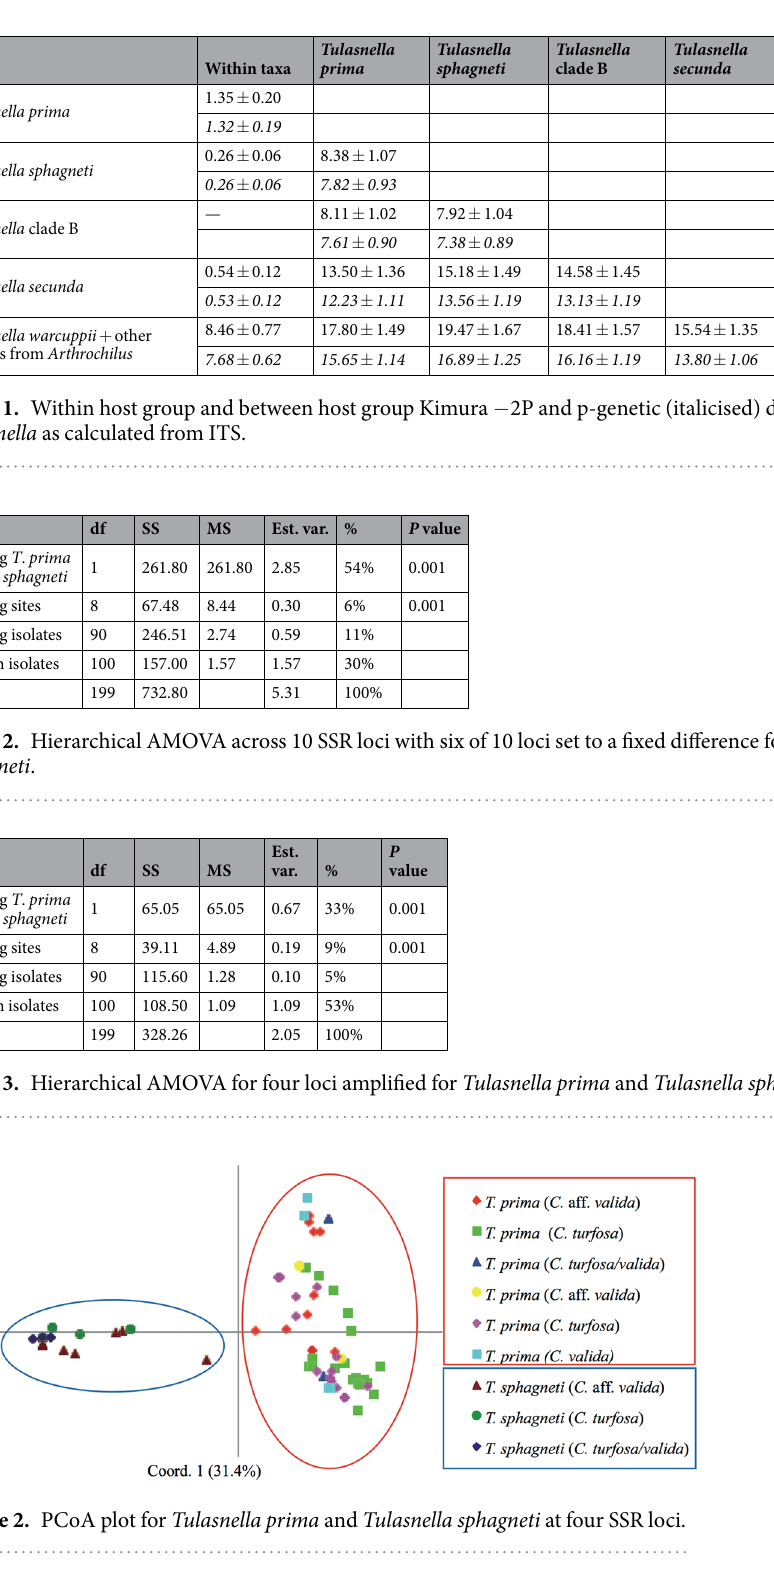
hierarchical multilocus analyses of molecular variance for T . prima from Kosciuszko National Park revealed that most of the variation is found within individuals (59%), with a large portion of the remaining variation explained by variation among individuals (29%) and some by among population differences (13%). However, the reduced number of amplifiable loci for T . sphagneti meant that we could not include this species in all population genetic analyses.